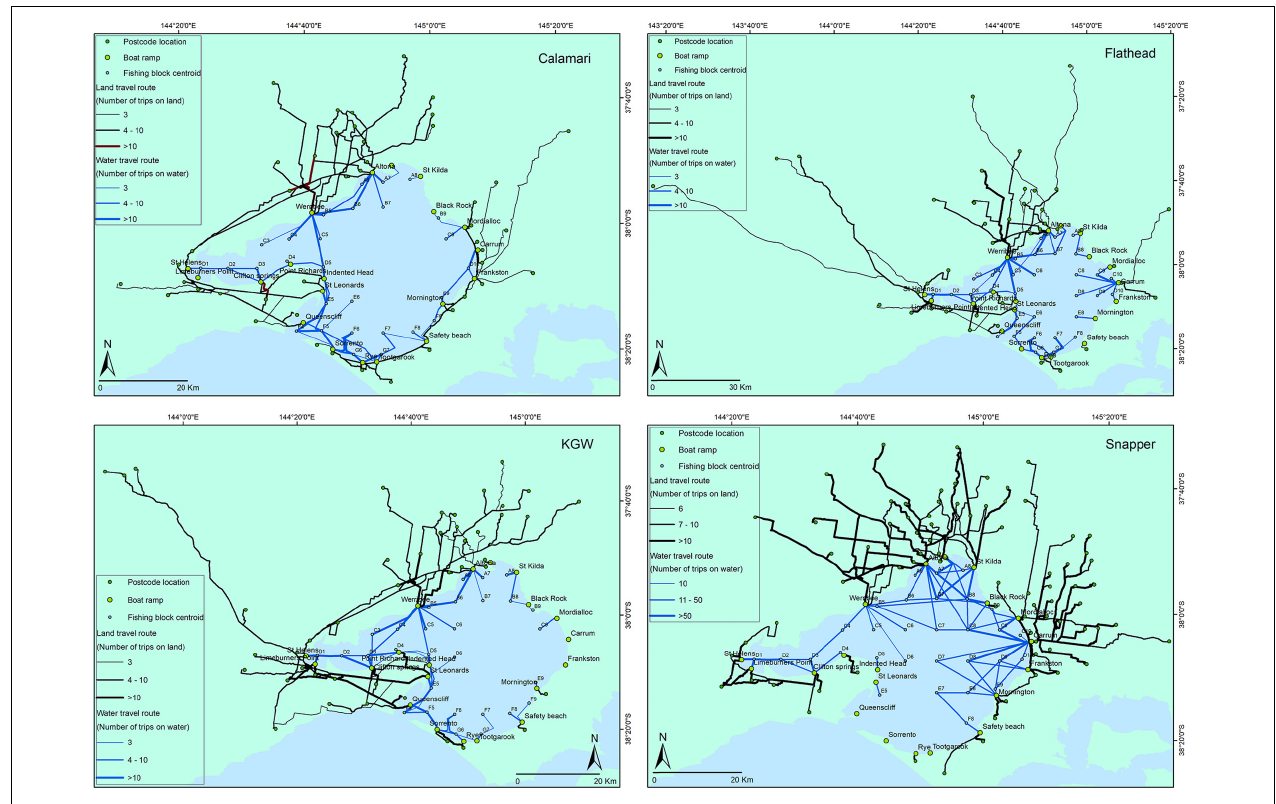
FIGURE 10 | Map of the most popular fishing trips over land and water (from residential postcode to the boat ramps and fishing blocks) to target the four main recreationally targeted species in Port Phillip Bay combined across years. These routes incorporate around 50% of all fishing trips on land, and over 80% of all fishing trips on